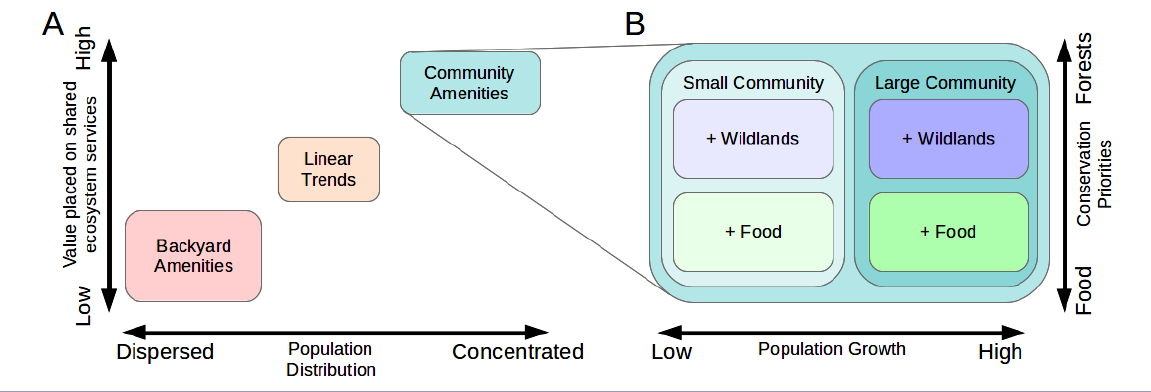
Fig. 2. Schematics of land cover scenarios. The three scenario families can be placed along a continuum from dispersed population with low value placed on shared ecosystem services to concentrated population with high value placed on shared ecosystem services (A), and the Community family is subdivided based on population growth and conservation priorities (B), giving a total of six scenarios: Backyard, Linear, Small Community + Wildlands, Small Community + Food, Large Community + Wildlands, and Large Community +